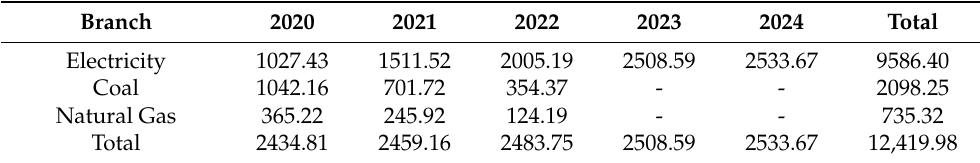
Table 6. Table of boiler module energy requirements in the boiler remediation scenario.